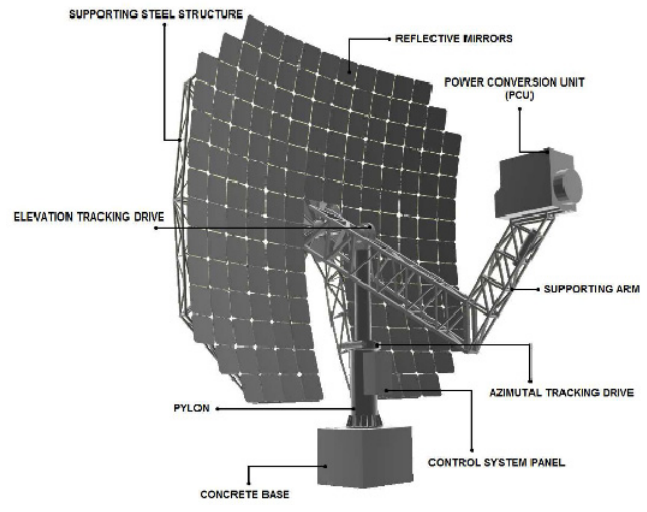
Figure 4. Sunflower 35 solar concentrator components [27].